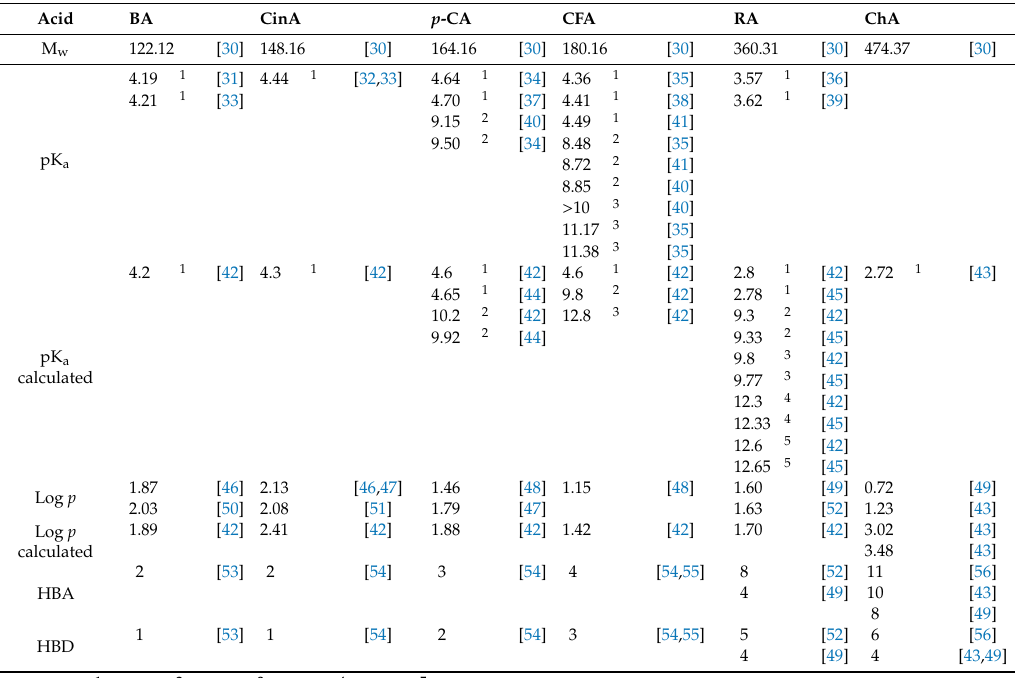
Table 2. The basic physicochemical parameters of